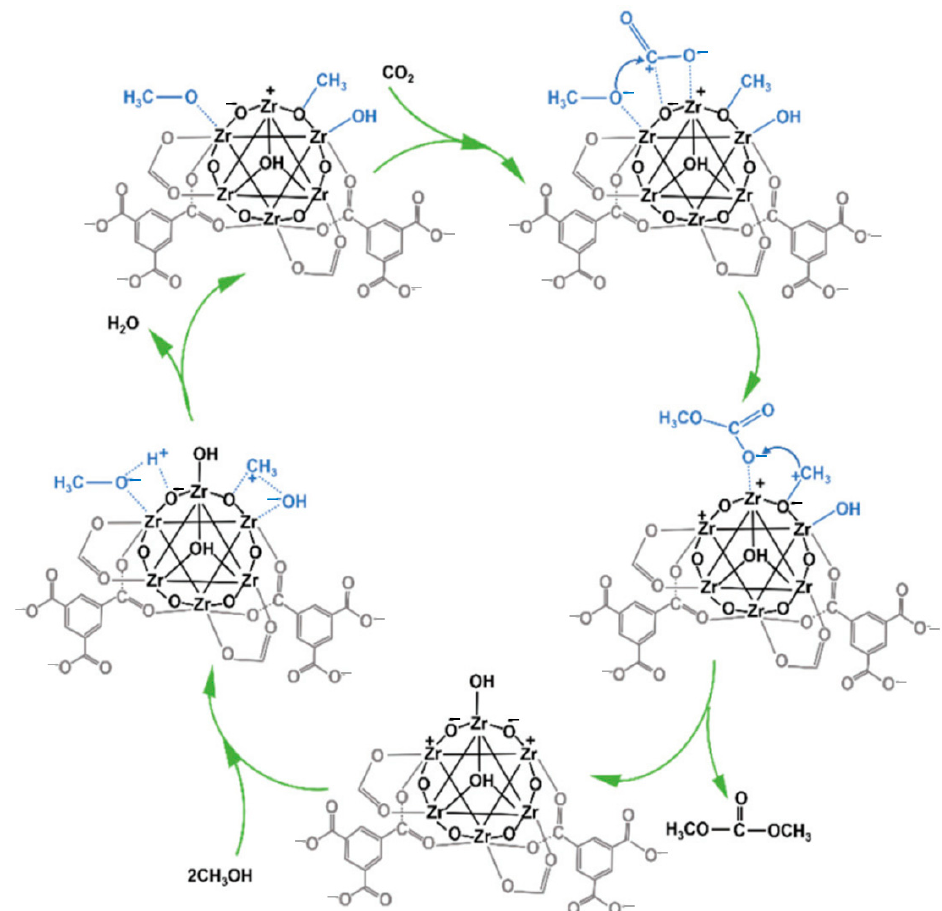
Figure 3. Proposed reaction mechanism for the direct synthesis of DMC from CO 2 and CH 3 OH over MOF-808. Reproduced with permission from Ref. [40]. Copyright 2018 Elsevier B.V.